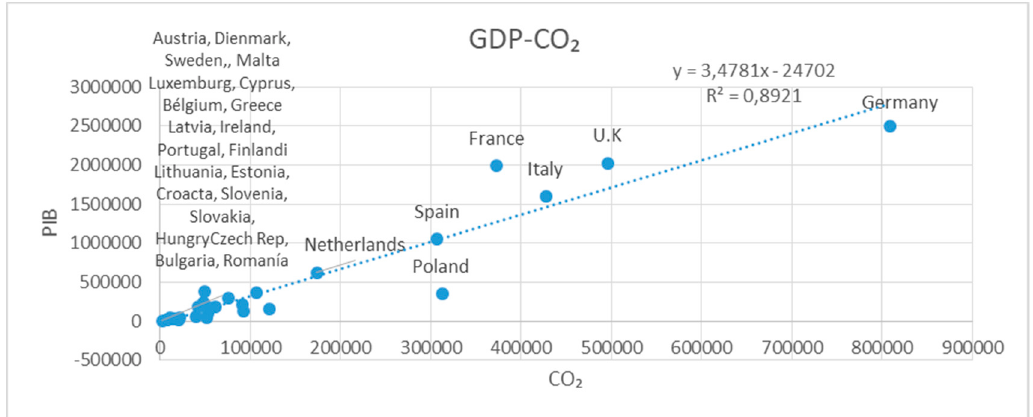
Figure 15. Relationship between average GDP values and average CO 2 emissions for the 28 EU countries in the period 2005–2012. Own